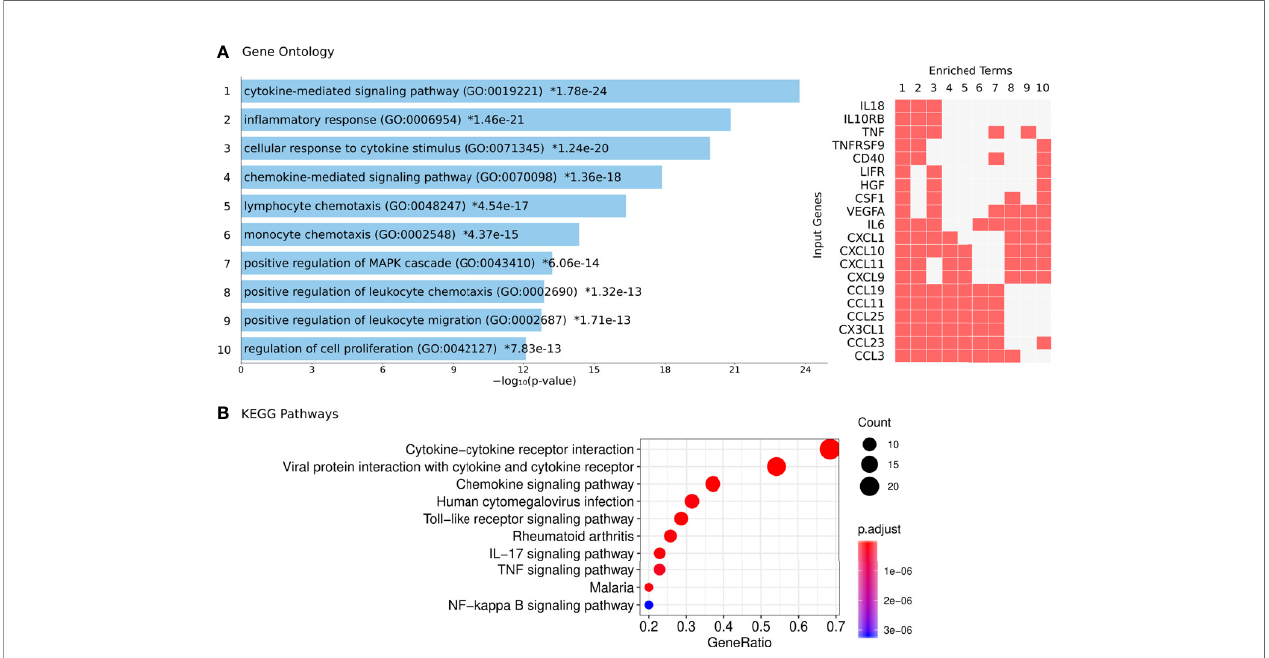
FIGURE 4 | Functional annotation of the differentially expressed plasma proteins in COPD patients. (A) Gene Ontology analysis: each bar represents a signi fi cant GO term with its P value for enrichment. Asterisks indicate signi fi cance after correction for multiple testing. The proteins detected in this study that coincide with those involved in each biological process (1 to 10) are indicated by a red box (right panel). (B) KEGG pathways with signi fi cant enrichment of differentially expressed proteins.